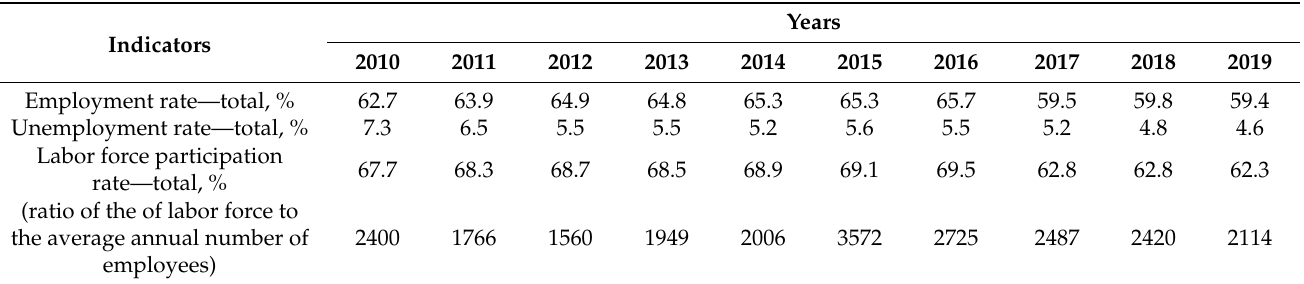
Table 3. Main indicators characterizing the macro-regional block “Labor” in the Russian Federation in